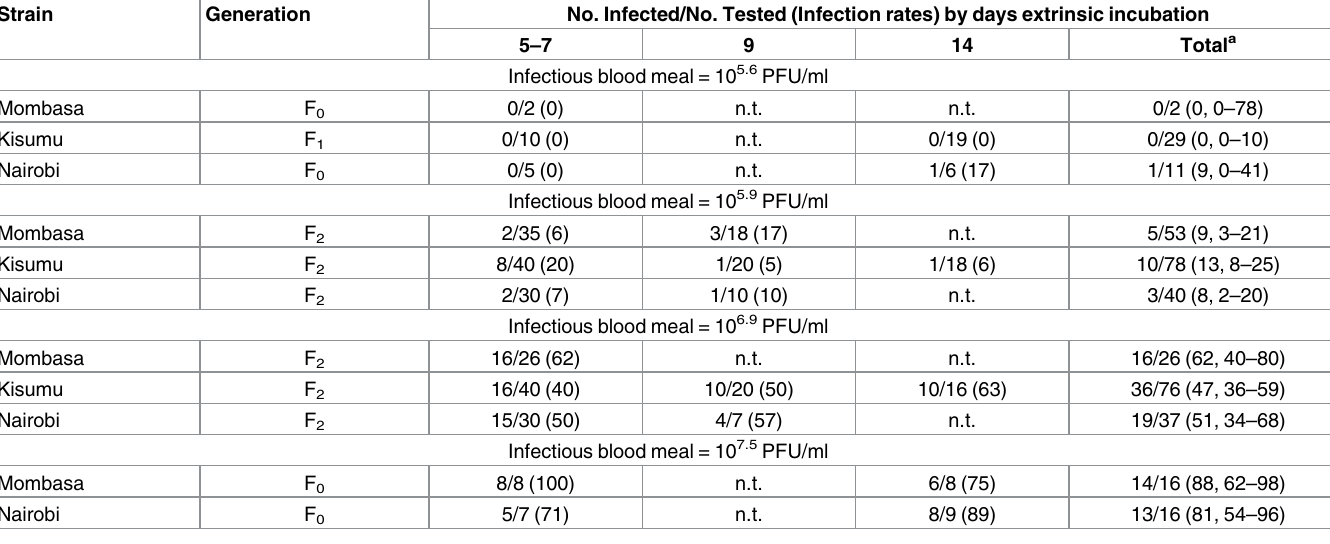
Table 2. Infection rates by day after feeding on a chikungunya virus blood meal.